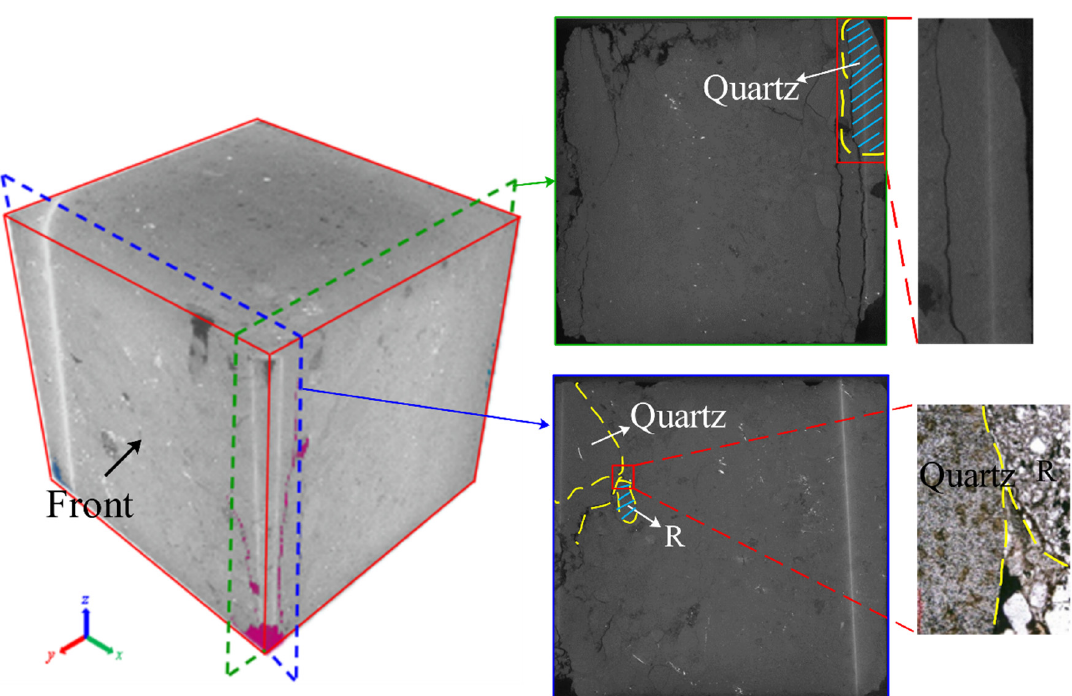
Figure 9. Results of fracture surface scanning. The meso-structural features at the source of fracture in rock sections of different orientations are shown, and it can be seen that the source of fracture there is the surrounding structure of quartz particles and R particles.